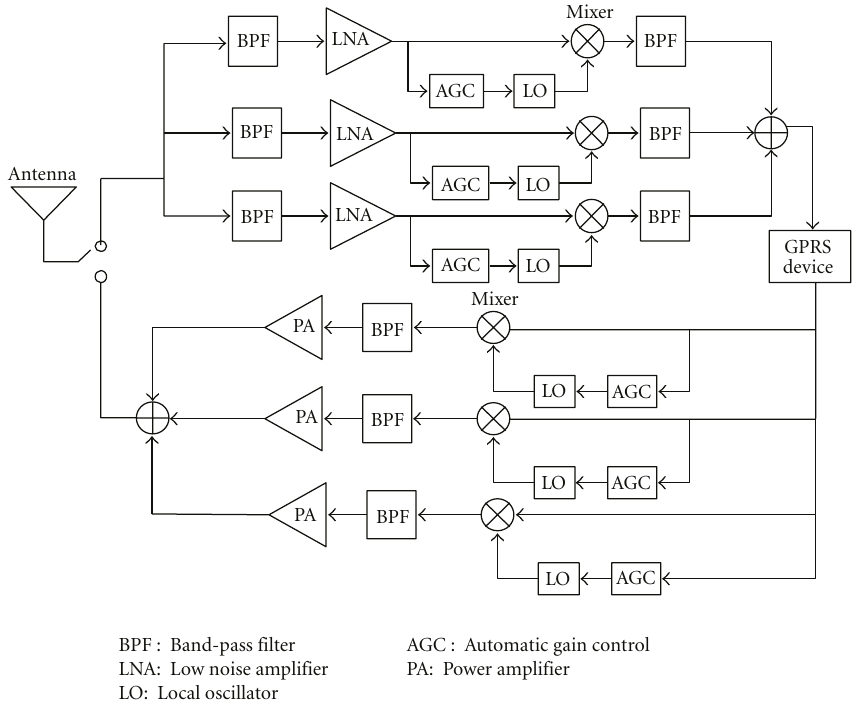
Figure 6: The GPRS mobile station can utilize all the channels through three up/down converter pairs.